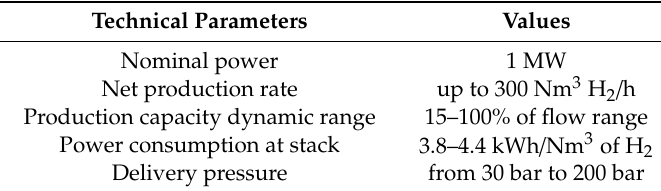
Table 1. Technical specifications of the P2G